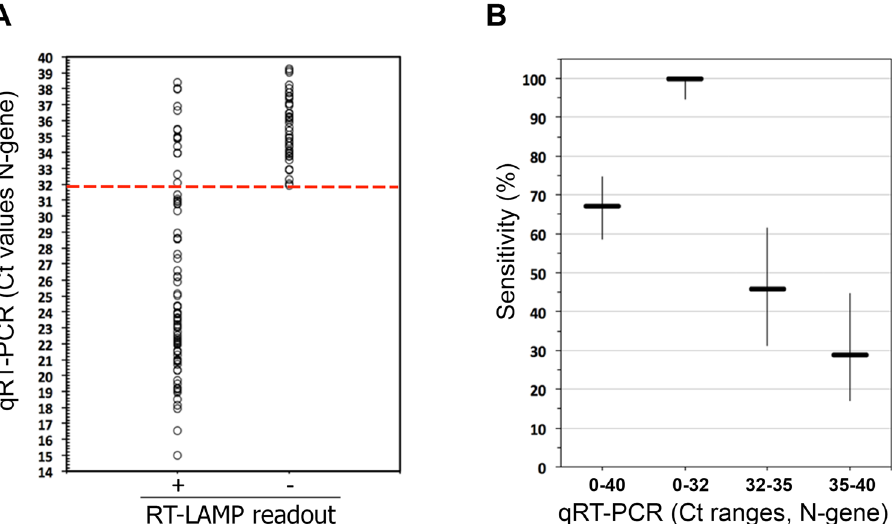
Figure 2. Detection of SARS-CoV-2 in NP samples using RT-LAMP. ( A ) Comparison of RT-LAMP and RT-PCR results. The Ct values (RT-PCR results) of 126 COVID-19 positive patients (y-axis) were compared to the RT-LAMP readout (x-axis) taken after 30 min of incubation at 65 °C (positive, +/yellow; negative, −/pink). The dotted red line indicates the Ct below, which there is 100% agreement between RT-LAMP and RT-PCR. ( B ) Sensitivity of the RT-LAMP assay across different ranges of Ct values (which reflect different viral loads). The thicker horizontal lines indicate the specificity calculated for the indicated Ct range (according to the data of panel ( A ) and Table 1). The vertical lines indicate the corresponding 95% confidence intervals.